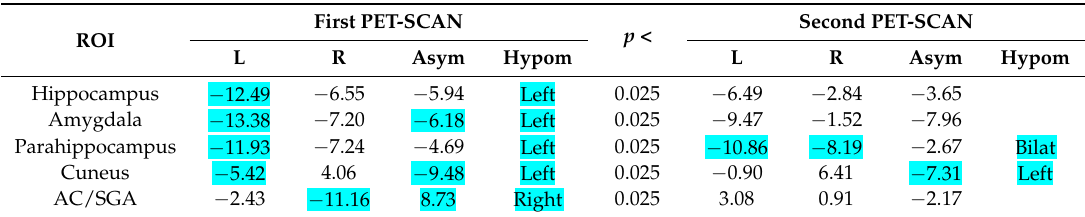
Table 2. Quantitative analysis of the metabolism (Neurocloud PET) in the regions of interest expressed as a percentage of deviation with respect to the normal population of the database, in the first and second PET-SCAN performed. The values highlighted in blue indicate a standard deviation <1.5 with respect to the mean of the normal population. L: Left side; R: Right side; Asym: Asymmetry; Hypom: Hypometabolism; Bilat: Bilateral; AC/SGA: Subgenual area of the anterior cingulate cortex. p : Statistical significance of each hypometabolism with respect to the normal population.